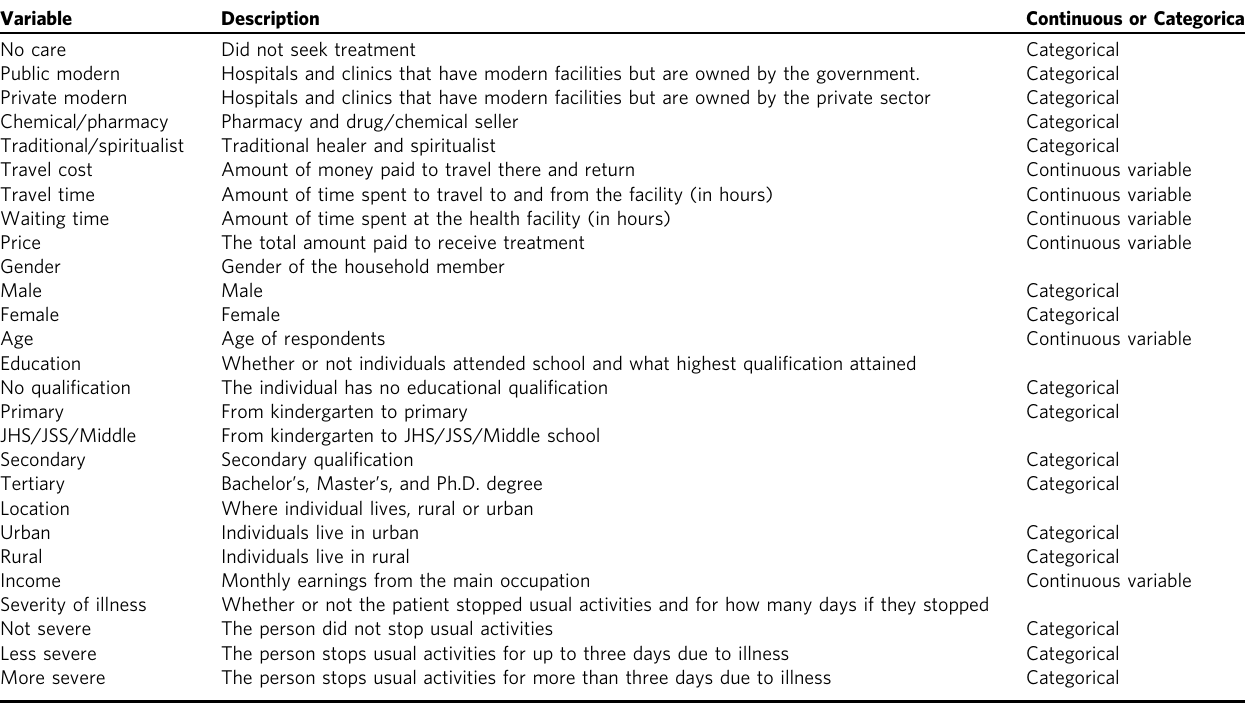
Table 1 Variable description: categorical and continuous